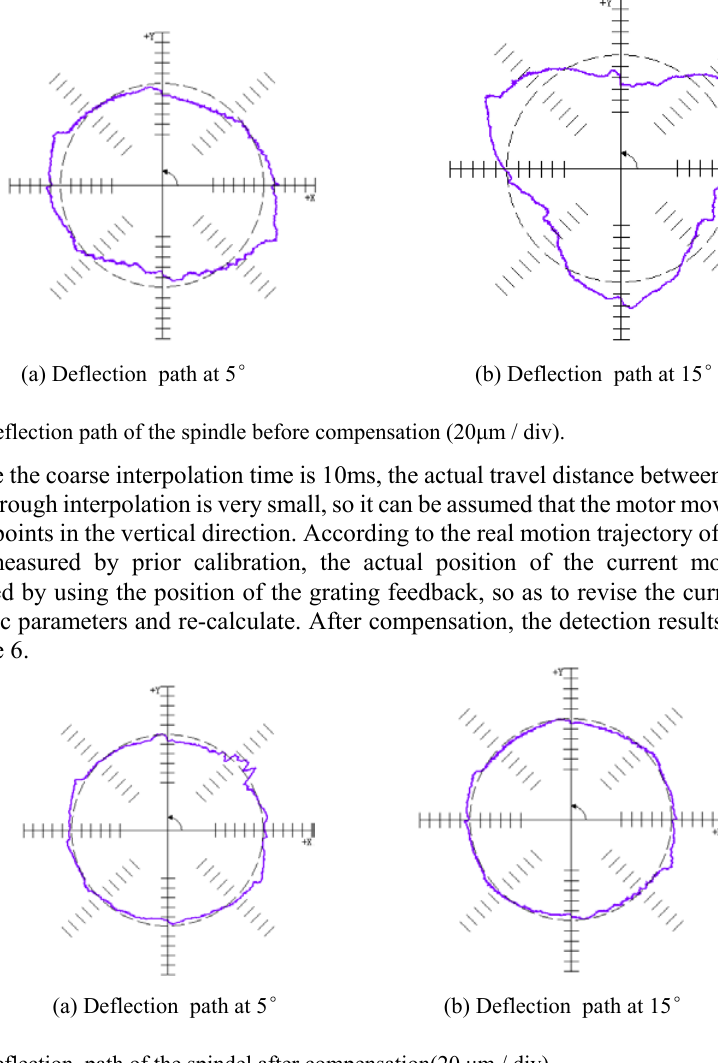
Fig. 6. Deflection path of the spindel after compensation(20 μm / div).